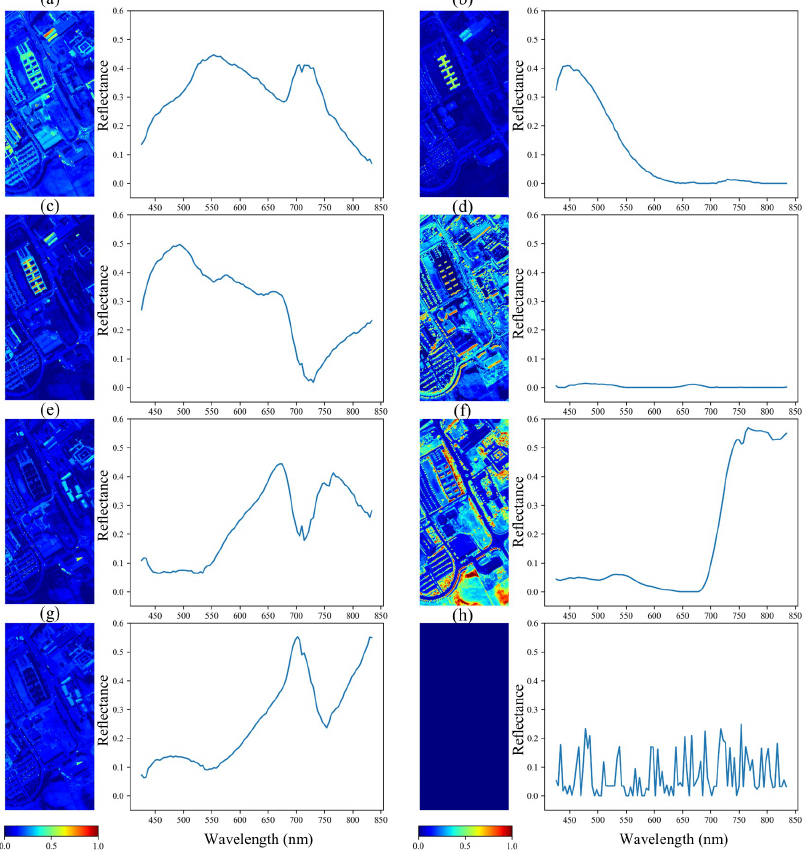
Figure 8. ( a – g ) shows the endmember spectral curves and corresponding abundance images extracted from the network with the Pavia University dataset. ( h ) shows invalid abundance and